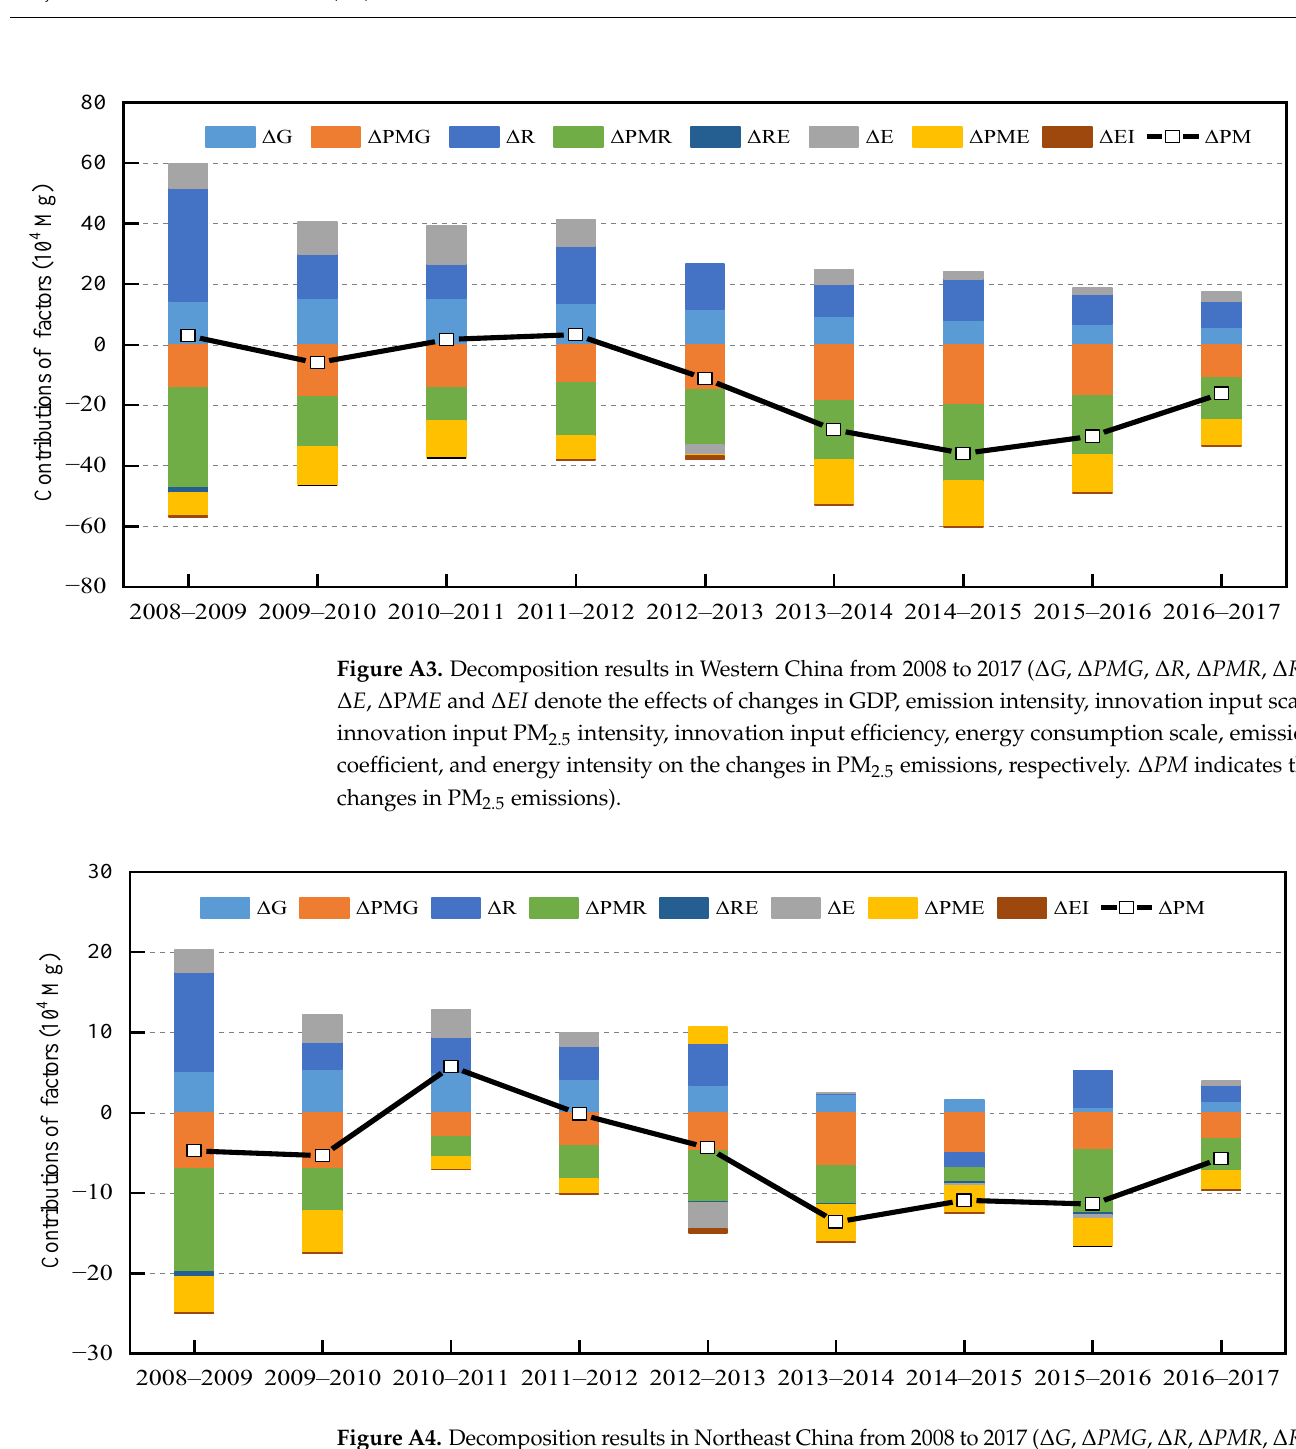
Figure A4. Decomposition results in Northeast China from 2008 to 2017 (Δ G , Δ PMG , Δ R , Δ PMR , Δ RE , Δ E , Δ PME and Δ EI denote the effects of changes in GDP, emission intensity, innovation input scale, innovation input PM 2.5 intensity, innovation input efficiency, energy consumption scale, emission coefficient, and energy intensity on the changes in PM 2.5 emissions, respectively. Δ PM indicates the changes in PM 2.5 emissions). Table A2. Decomposition results in China over different periods (unit: %).